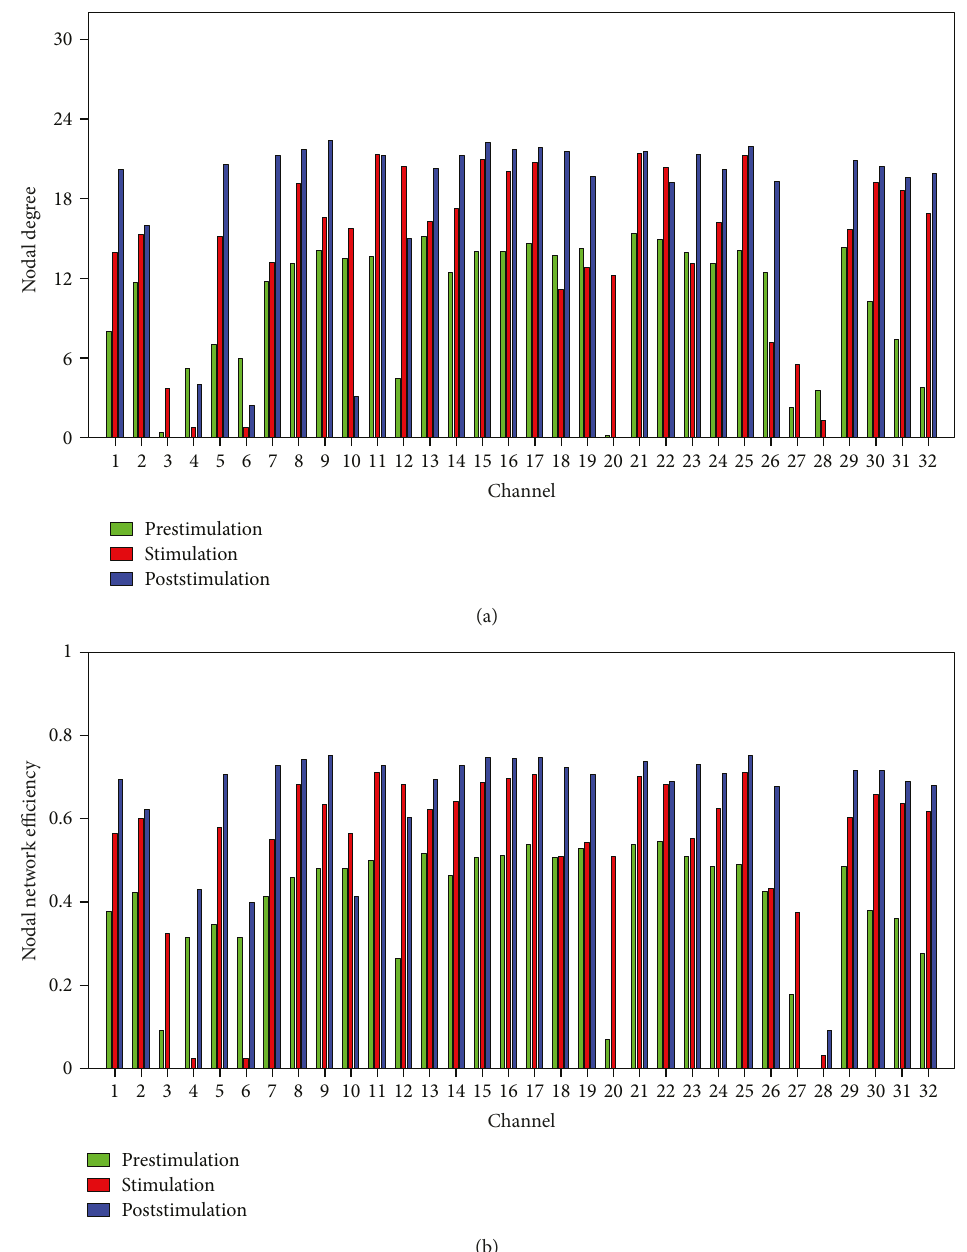
Figure 6: Nodal network metrics for all phases: (a) degree and (b) network e ffi